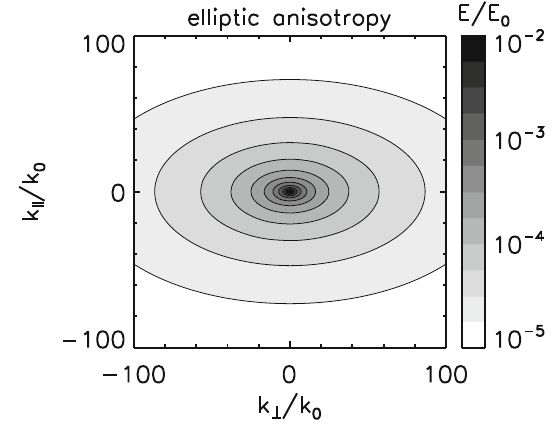
Fig. 14 Energy spectrum in the wavevector domain for the elliptic model. The coordinates and the normalizations are the same as that in Fig.13. The elliptic shape is set to a coefficient of c = 0 .